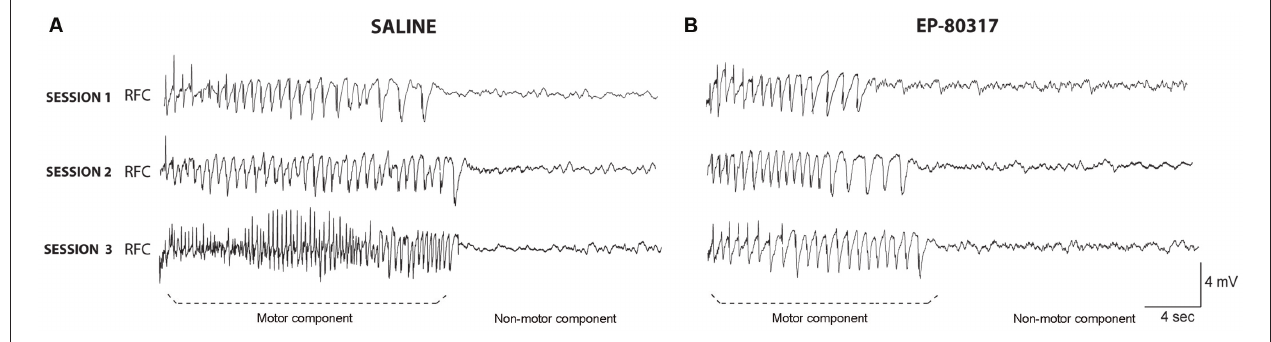
FIGURE 2 | Electrocorticographic (ECoG) activity during seizures induced by 6-Hz corneal stimulation. EcoG traces obtained from frontal cortex of one out of three representative mice. Note that the trace clearly shows two components: (i) the ictal event corresponding to the motor component of the seizure; and (ii) the post-ictal event, characterized by flattening of basal activity corresponding to the non-motor component of seizures. Traces were respectively taken from a saline-treated mice (A) or an animal treated with EP-80317 (B) . No quantification is provided because of the low number of animals per group ( n = 3). RFC, right frontal